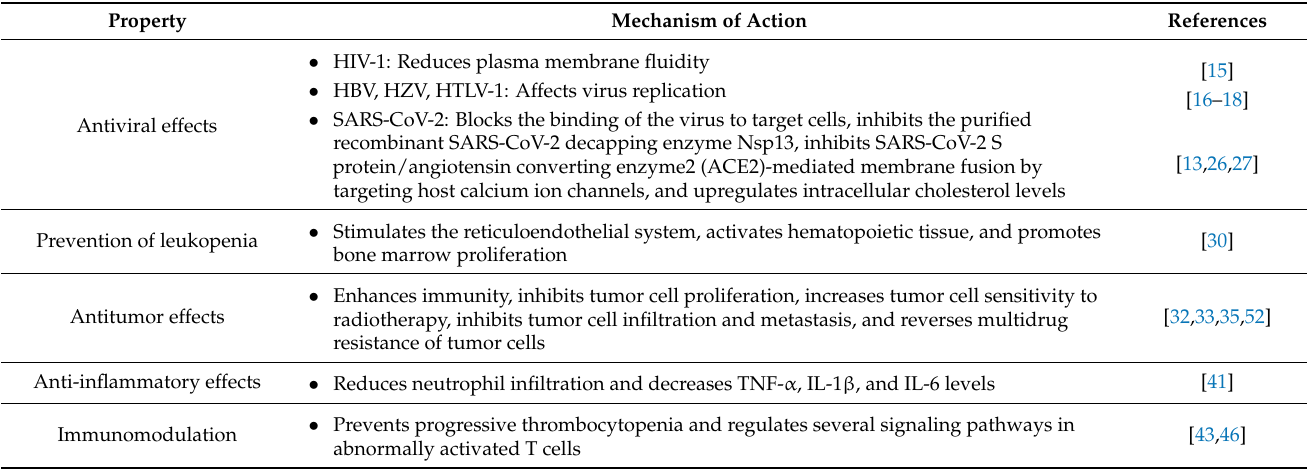
Table 2. Pharmacological effects of